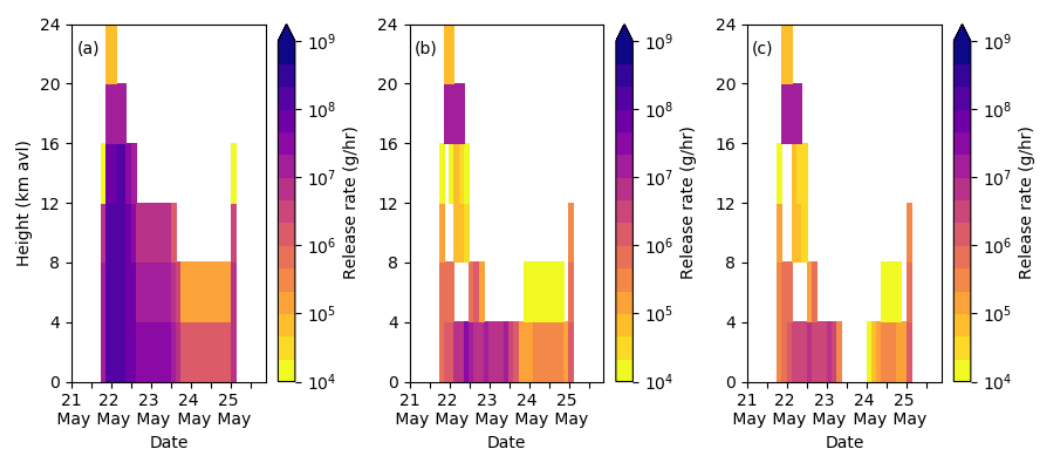
Figure 5. ( a ) a priori ( b ) ensemble mean posterior with wet deposition represented ( c ) ensemble mean posterior without wet deposition represented time-height emission profile (g/h) determined by InTEM for the Grímsvötn eruption (21–25 May 2011). Note the log scale used for the release rate.